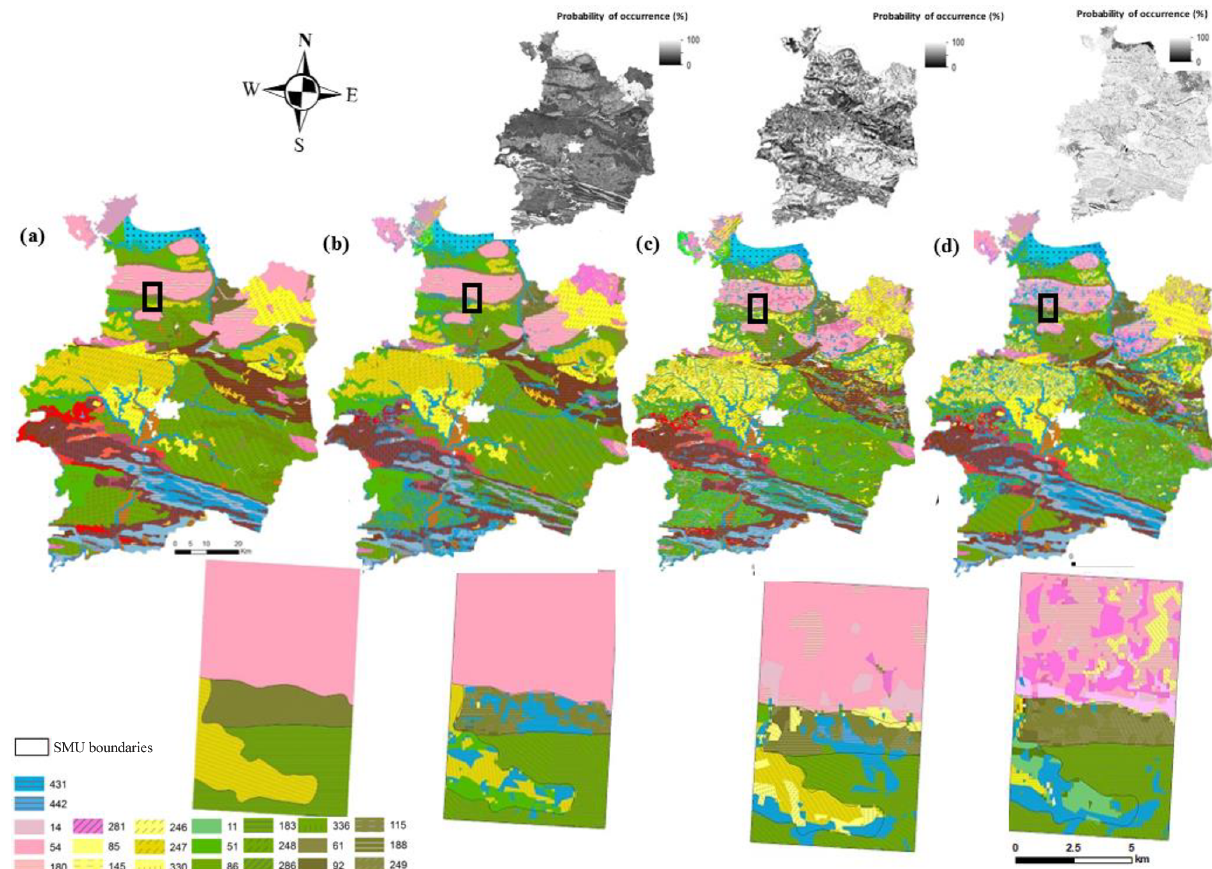
Figure 3. Digital soil map of the most probable STUs and their associated probability of occurrence for the whole study area and for a focus zone. The legacy soil map shows the (a) most probable STUs for each SMU, (b) original DSMART approach, (c) DSMART with expert rules and (d) DSMART with extra soil